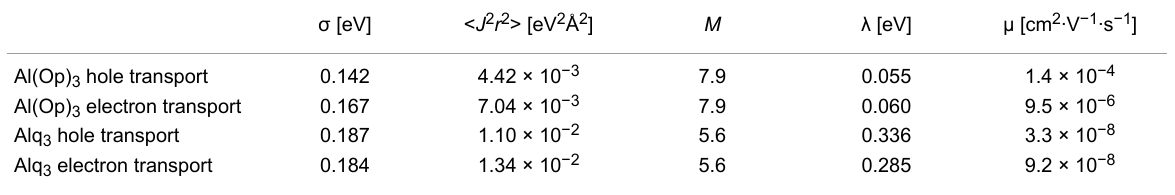
Table 2: Microscopic parameters and charge carrier mobility for Al(Op) 3 and Alq 3 used as input in Equation 1. σ [eV]